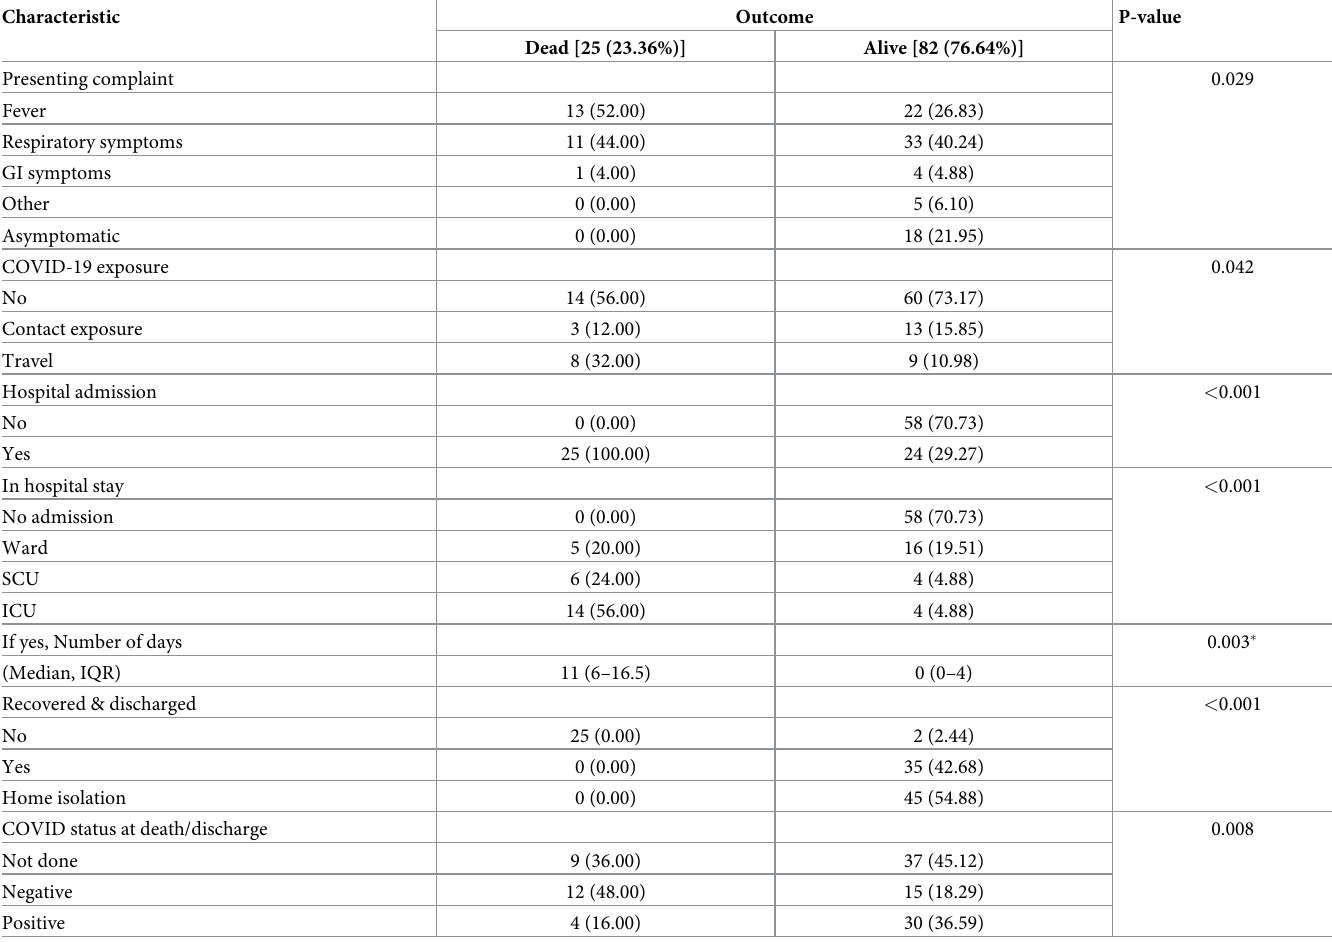
Table 3. COVID-19 exposure and status at death/discharge among hematological malignancies patients stratified on outcome (n = 107).